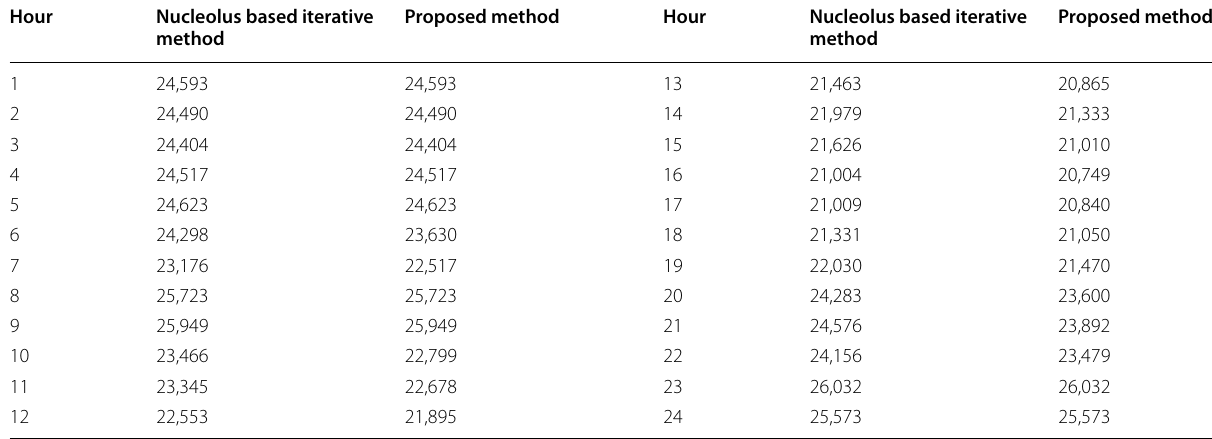
Table 7 Comparison in terms of emissions (kg) Hour Nucleolus based iterative Proposed method Hour Nucleolus based iterative method